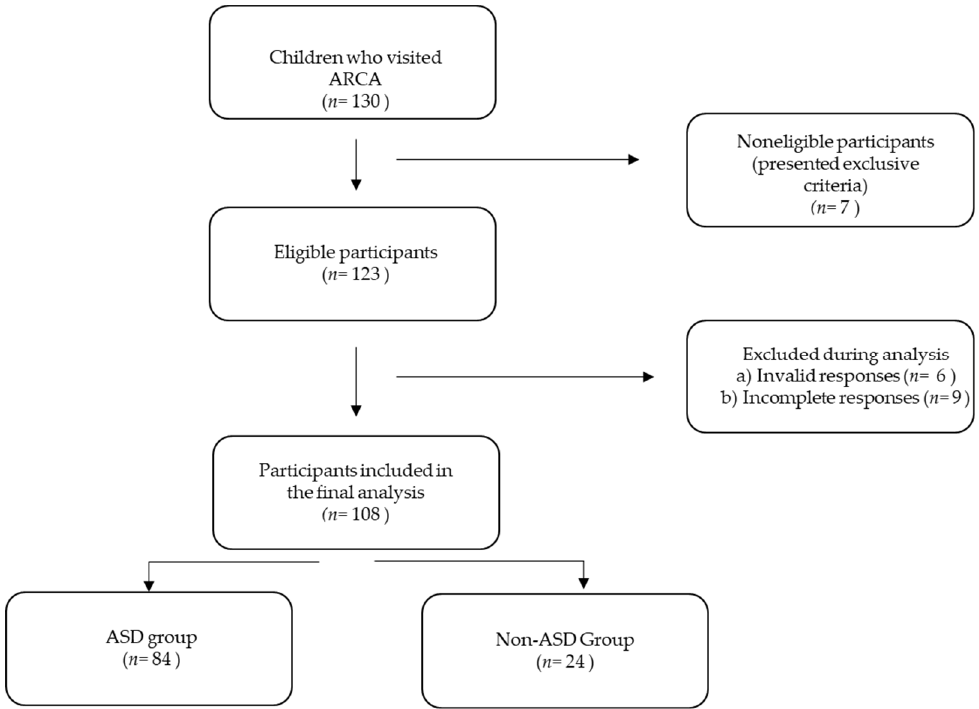
Figure 1. Flowchart diagram of subjects’ recruitment. ARCA—Academic Research Center for Autism; ASD—autism spectrum disorder. Table 1. Demographic characteristics of the sample.